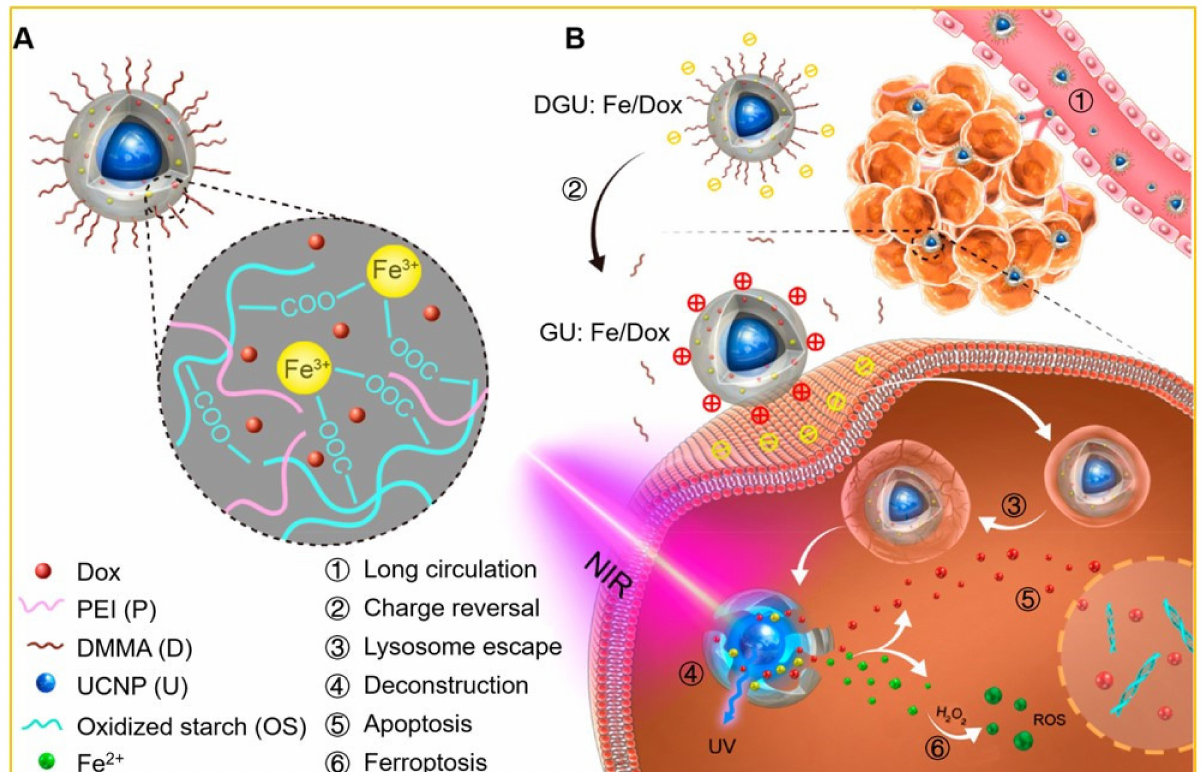
Figure 4. ( A ) Fe 3+ -linked carrier: UCNP (core) and Dox (absorbed in the polymer shell). ( B ) Anticancer mechanism of the UCNP-based system. 1 (cid:13) Passive accumulation of DGU:Fe/Dox with extended circulation and enhanced EPR. 2 (cid:13) Change from DGU:Fe/Dox (negative) to GU:Fe/Dox (positive) at tumor site driven by pH activation. 3 (cid:13) Lysosome escape of GU:Fe/Dox through proton sponge. 4 (cid:13) Deconstruction of NIR-responsive system under the action of UCNP. 2464 Apoptosis of released Dox in the cell nucleus. 6 (cid:13) Ferroptosis of ROS with tumor cellular H 2 O 2 at the cytoplasm. Adapted with permission from